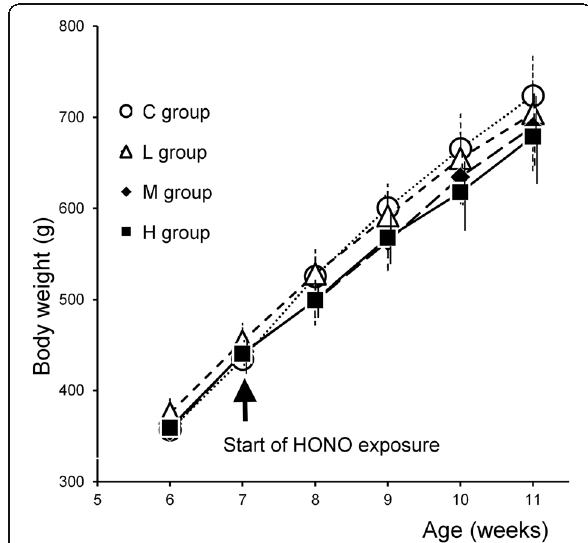
Fig. 1 The transition of the body weight in each group. No significant differences were found by